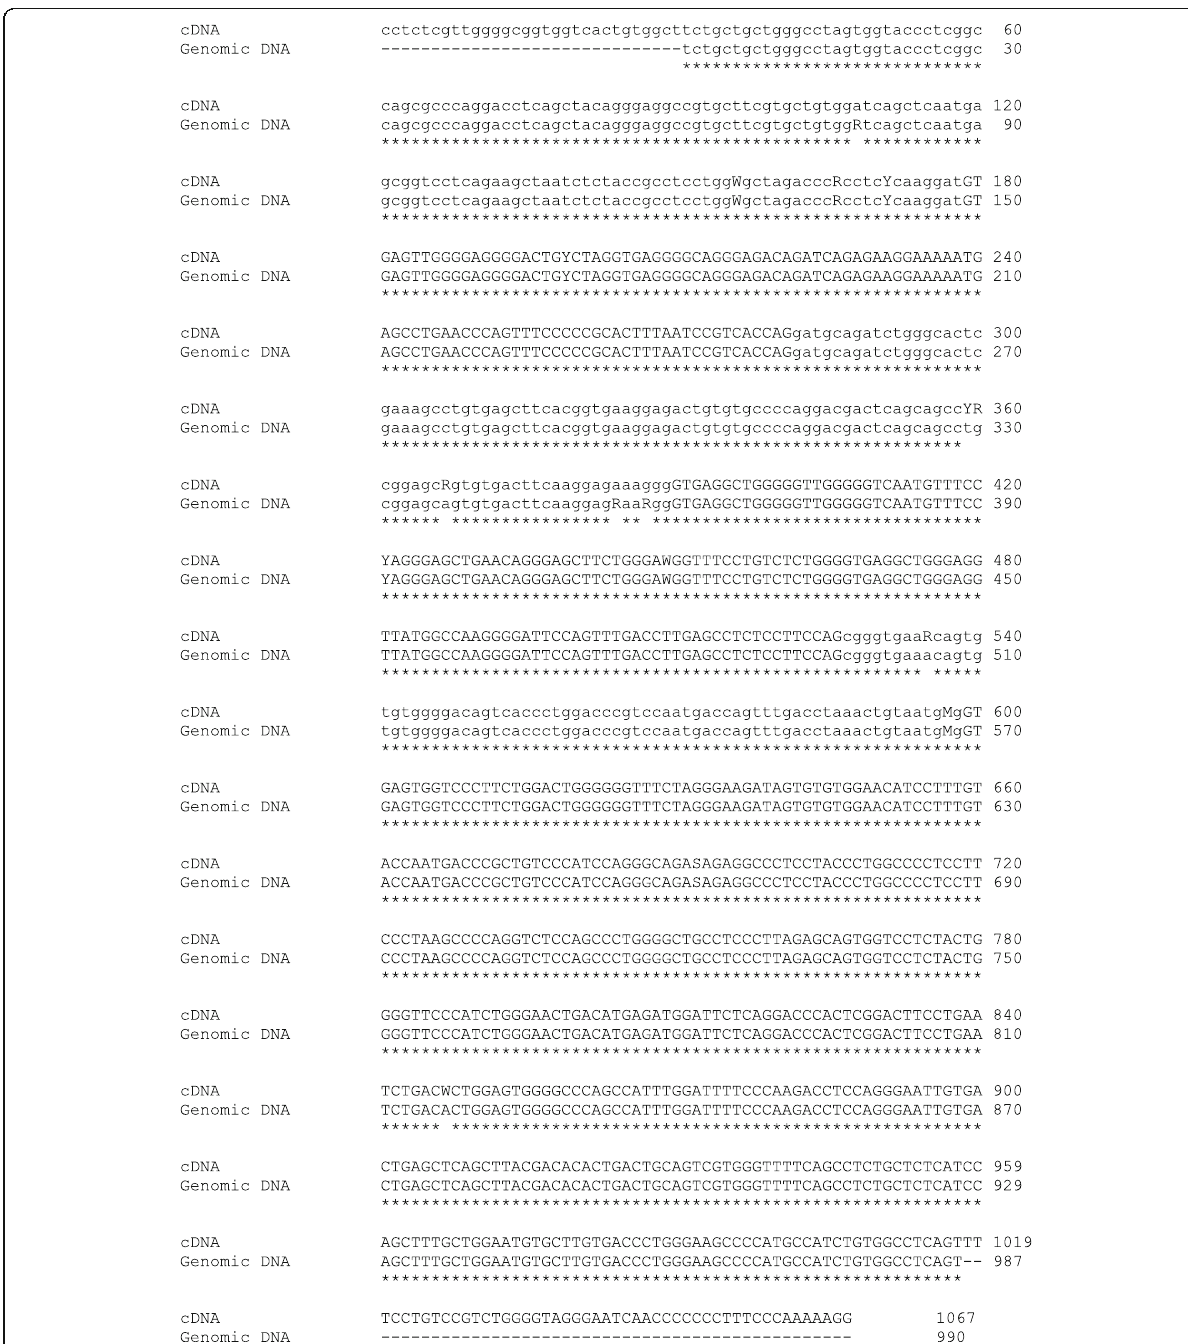
Fig. 4 Multiple sequence alignment of buffalo CATH4 genomic DNA and 1067 bp cDNA. Introns are in capital; exons 1, 2, and 3 are in small letters. SNPs: M(A/C), R(G/A), K(T/G), Y( C/T), S(G/C), and